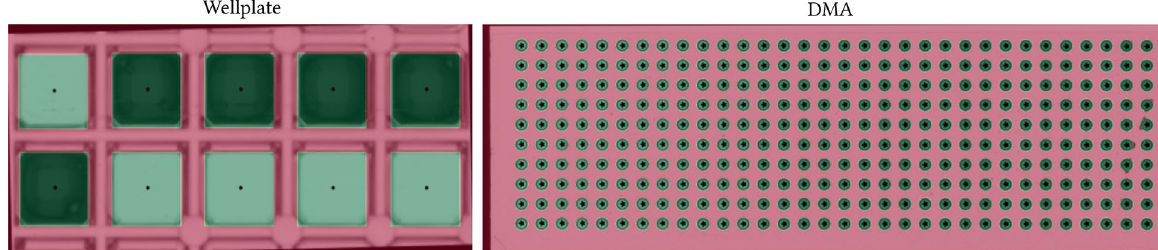
Figure 11. Grid Detection. The automated grid estimation using Grid Screener is shown for wellplate and DMA input images. The grid elements are marked via crosses (centroid) and green overlays. A red overlay denotes the background. ID Area Eccentricity Mean intensity Major axis Minor axis,